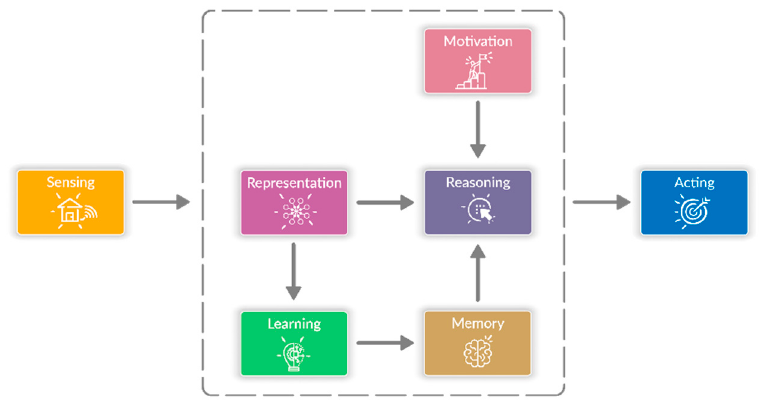
Figure 1. Main elements of an AI